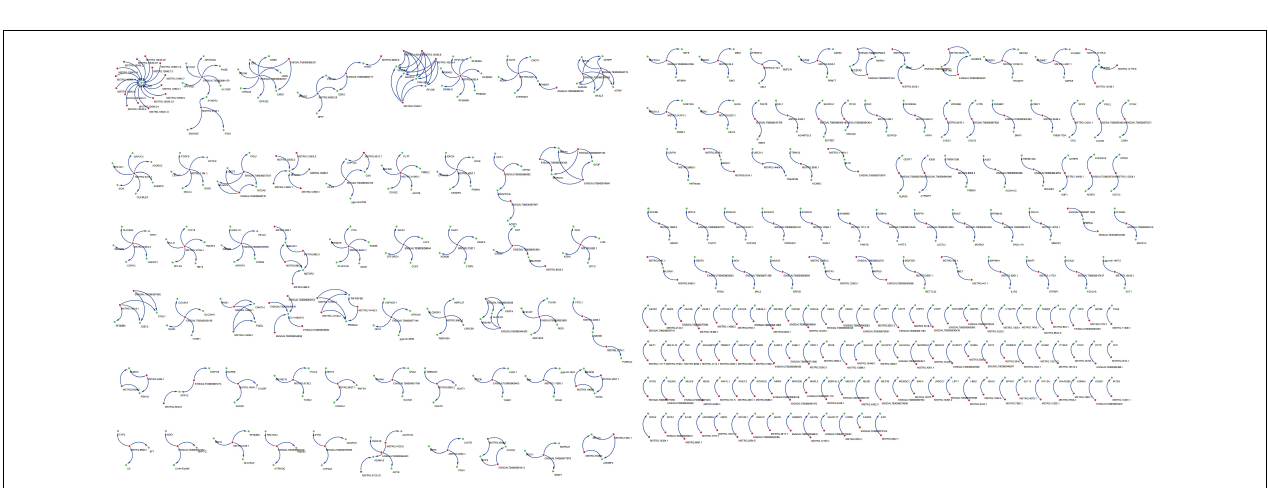
FIGURE 3 | Differentially expressed lncRNAs in H5N1-infected chicken DF1 cells. (A) Cluster analysis of the expression patterns of differential lncRNAs at 0, 6, 12, and 20 hpi. (B) The trends in differential lncRNAs expression patterns at 0, 6, 12, and 20 hpi.